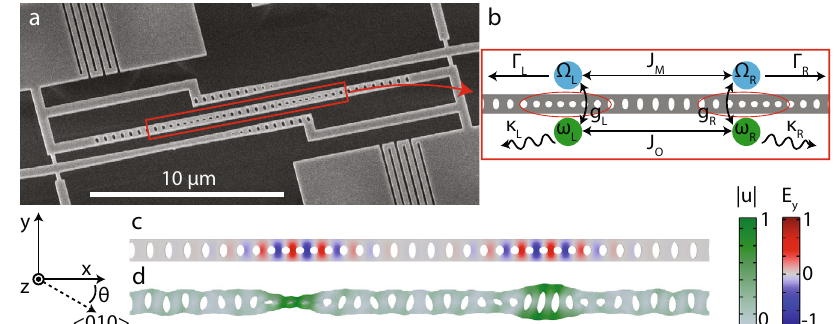
Fig.1|Coupled-modedevicedesign.a Ascanningelectronmicroscopeimageofa fabricated device with nanobeam, waveguides and support structure. b Schematic of the mode frequencies and coupling rates in the double-cavity nanobeam. c The simulated y -componentoftheelectrical fi eldfortheevenopticalsupermode. d The